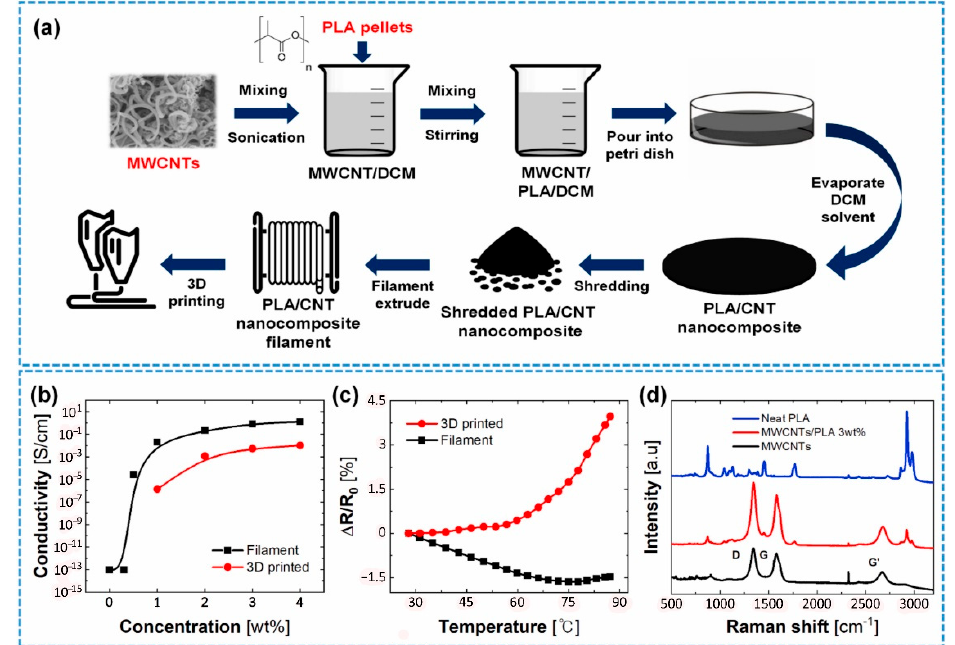
Figure 8. ( a ) Schematic process of the composite filament production. ( b ) Electrical conductivity of the filament and 3D printed sample of MWCNT composite. ( c ) Relative resistance changes-temperature curve of the 3 wt% filaments and 3D printed sample. ( d ) Raman spectroscopy of pristine PLA, MWCNT, and MWCNTs/PLA composite. With permission [39].